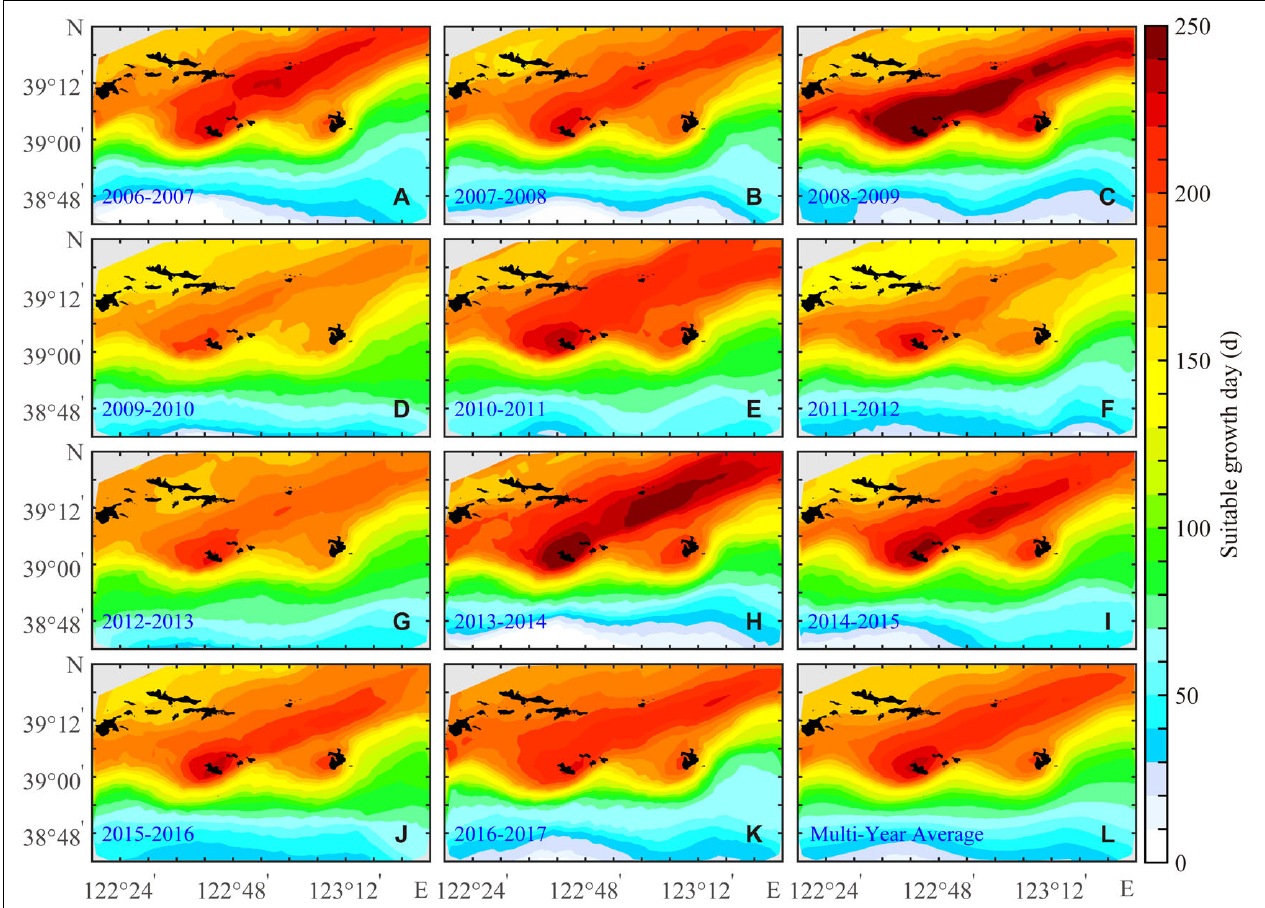
FIGURE 4 | Annual (A–K) and the multiyear average (L) of suitable growth days for the Yesso scallop ( P. yessoensis ) in the Changhai sea area, China, from December 1, 2006 to November 30, 2017.